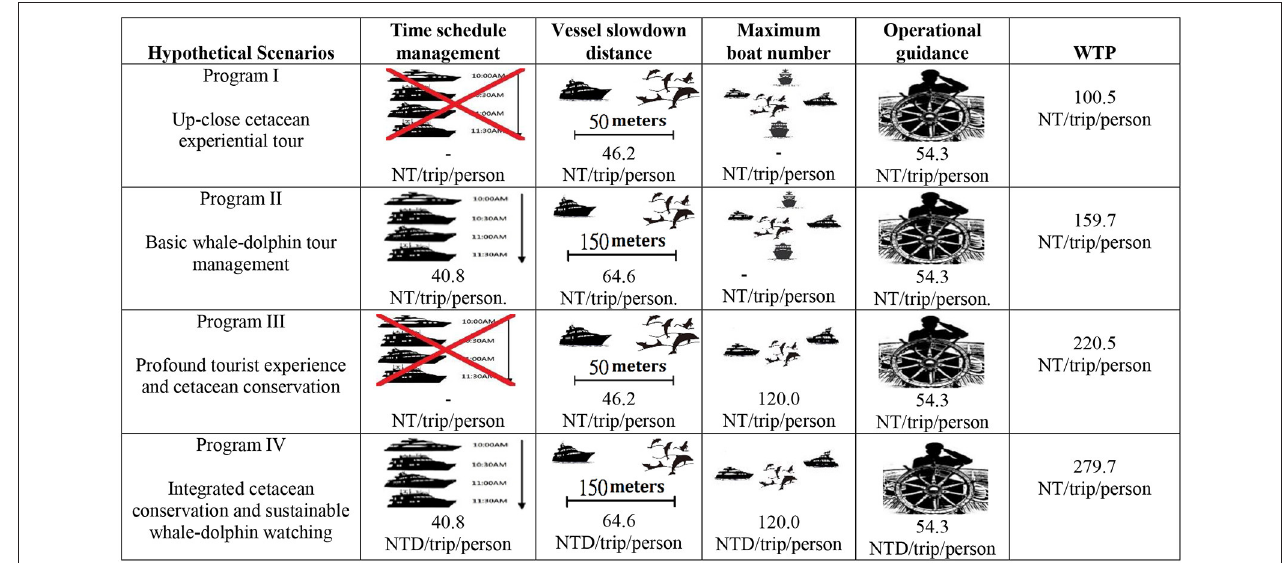
FIGURE 3 | The MWTP effects for impact mitigation program for sustainable whale and dolphin